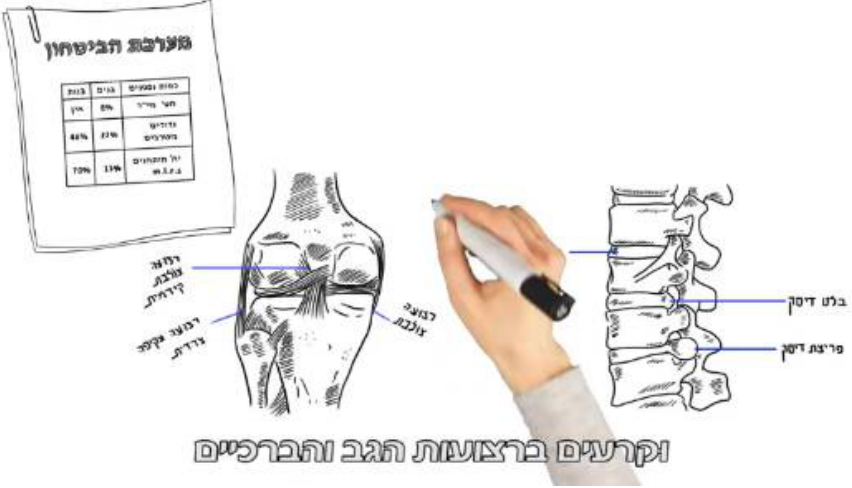
Figure 3. ‘The integration of women fighters’ (The IDF Fortitude Forum, August 2017). [Hebrew wording in the picture: Top Left corner: “The Security System”; Bottom left: “Anterior cruciate ligament”, “Cruciate ligament”, “Lateral collateral ligament”; Bottom right: “Herniated Disk”, “Spinal disc herniation”] (Supplementary material).